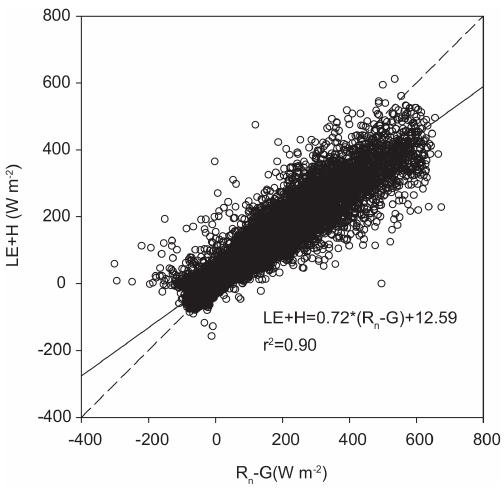
Figure 4. The daily variations in averaged sensible heat ( H ), latent heat (LE), net radiation ( R n ) and soil heat flux ( G ) during 2012– 2013.